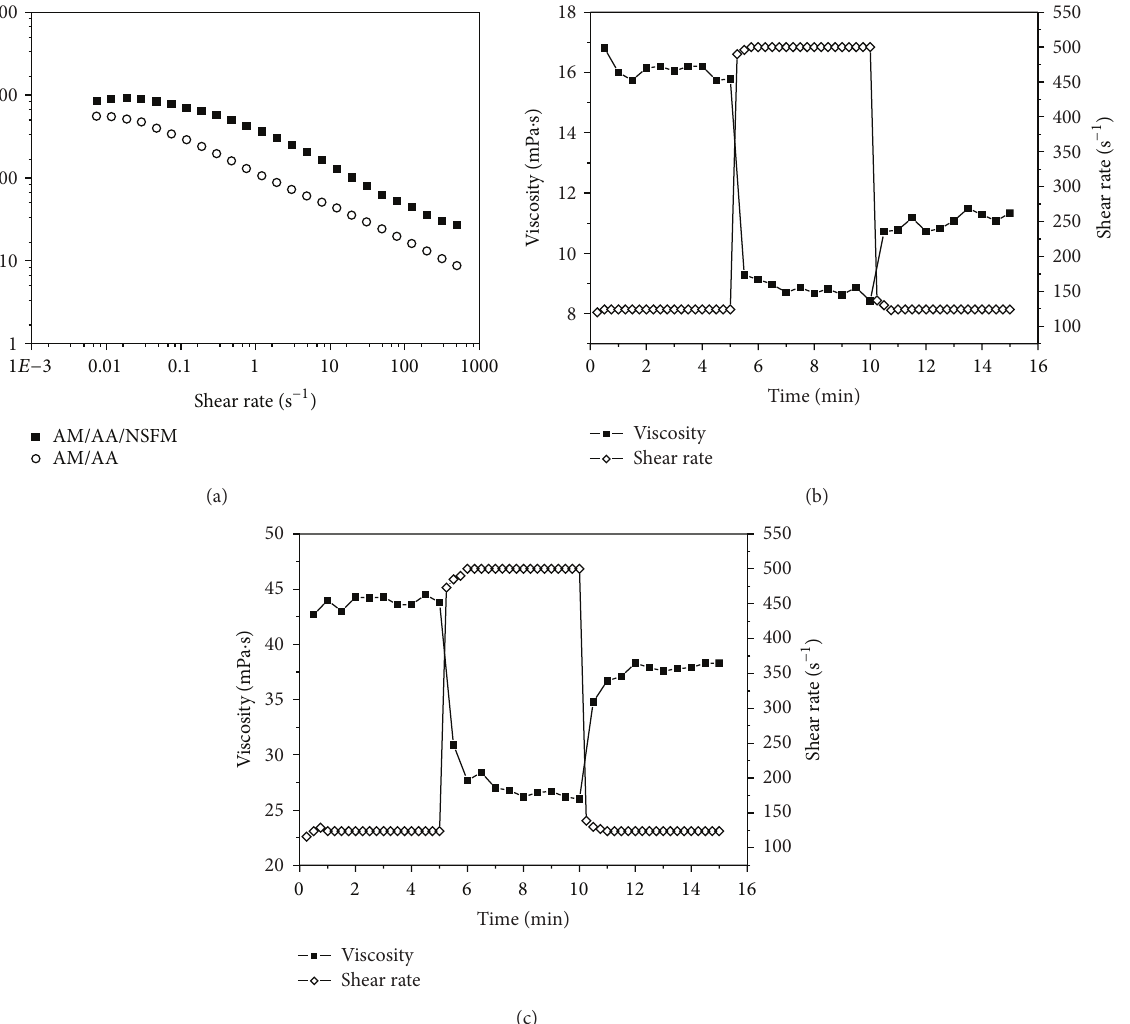
Figure 7: (a) Effect of shear rate on viscosity; (b) shear resistance of AM/AA; (c) shear resistance of AM/AA/NSFM. The copolymers solutions (0.2wt%) were prepared with distilled